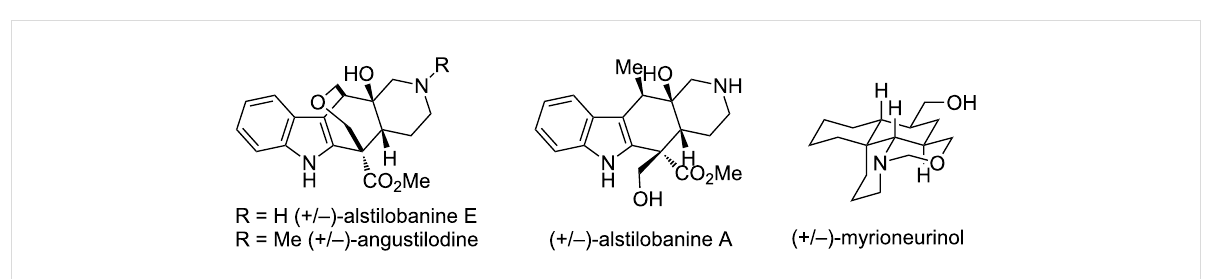
Figure 1: Alkaloids synthesized using stereoselective Michael addition to conjugated